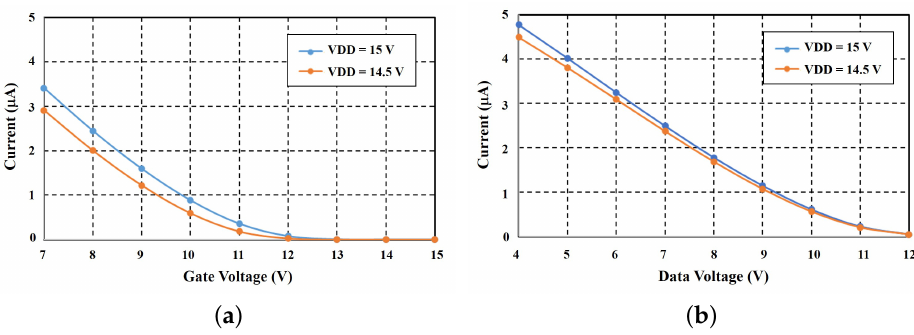
Figure 17. OLED currents over VDD variation of − 0.5 V: ( a ) without pixel compensation; and ( b ) with pixel